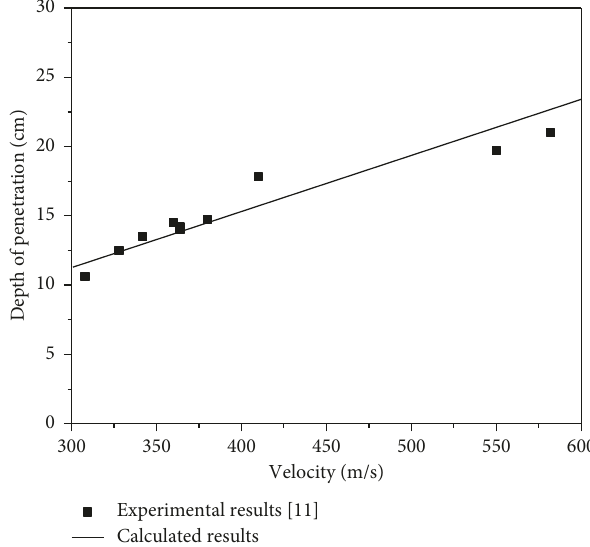
Figure 23: The experimental data of the RPC